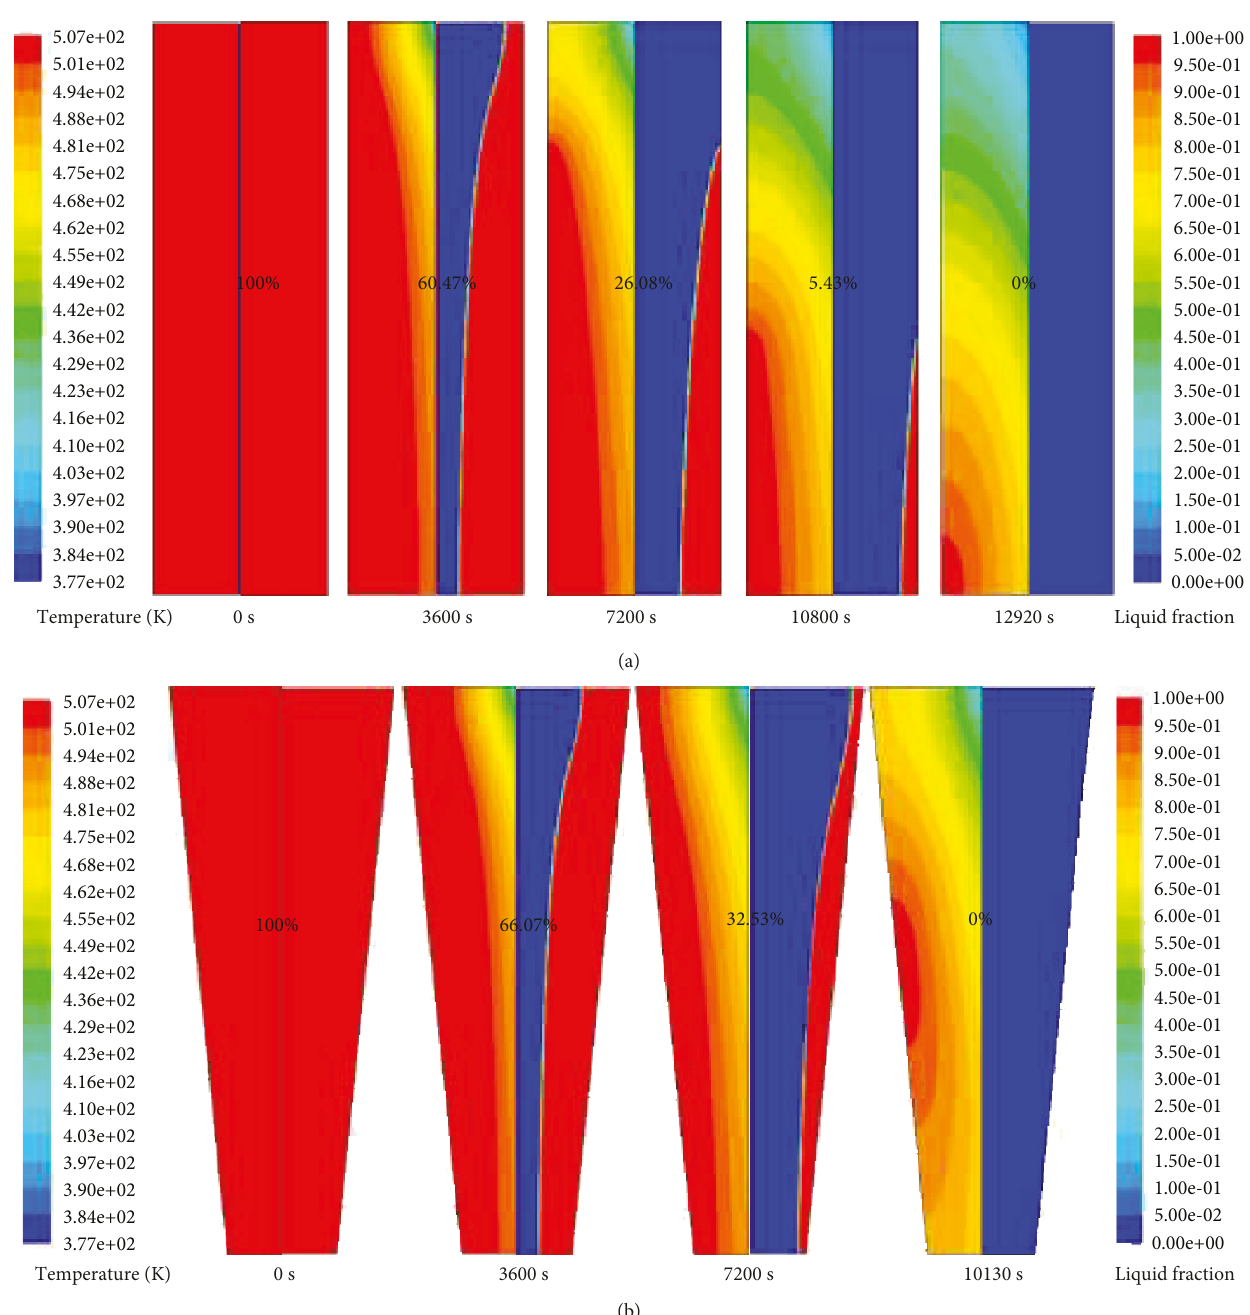
Figure 12: Contour of the PCM temperature (left) and liquid fraction (right) in the (a) cylindrical and (b) truncated cone model during the solidi fi cation